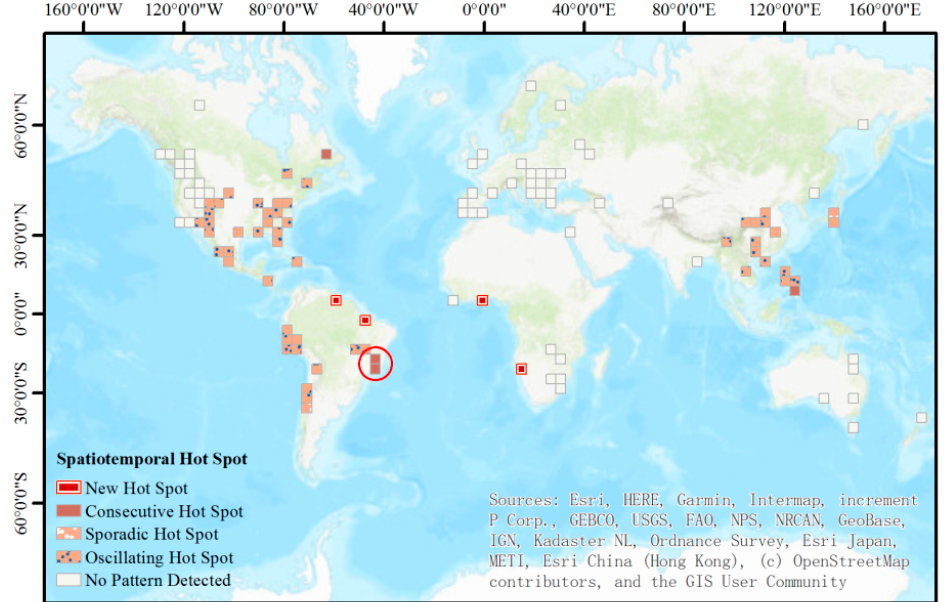
Figure 11. Spatiotemporal hot spot analysis of tailings dam failures. The location of Brumadinho dam disaster is marked with red circles.